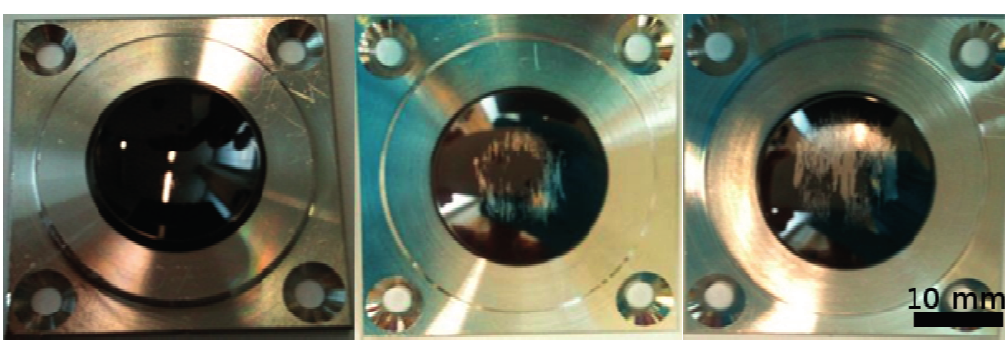
Figure 7. Delamination observed on coated articulation pairs (concave parts) with increasing interlayer oxygen contamination. Left : R = 0, 80 million cycles; center : R = 5 × 10 − 4 , 100,000 cycles; right : R = 6.4 × 10 − 2 , 100,000